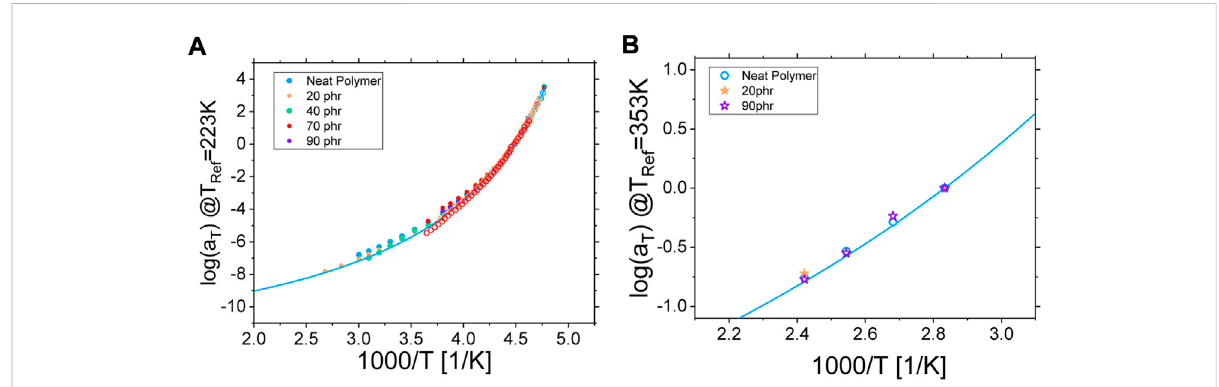
FIGURE 6 (A) Rheological( fi lledcircles)anddielectric(emptysymbols)horizontalshiftingfactorlog( a T )plottedasafunctionofinversetemperature 1000/ T for boththeneat polymer(blue) andthecompositesamples. Here,thereference temperaturewassetto223 K.The solidblueline isaVFT fi tofthe α -relaxation of the neat polymer measured by dielectric spectroscopy. (B) NSE horizontal shifting factor log ( a T ) plotted as a function of inverse temperature 1000/T for both the neat polymer (circles) and the composite samples (stars). Here, the reference temperature was set to 353 K. The solid blue line is an extrapolation of the VFT fi t performed on the dielectric data of the neat polymer.